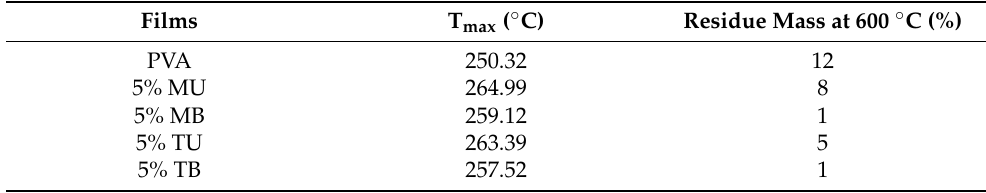
Table 2. T max of pure PVA and 5% PVA-(L)CNF